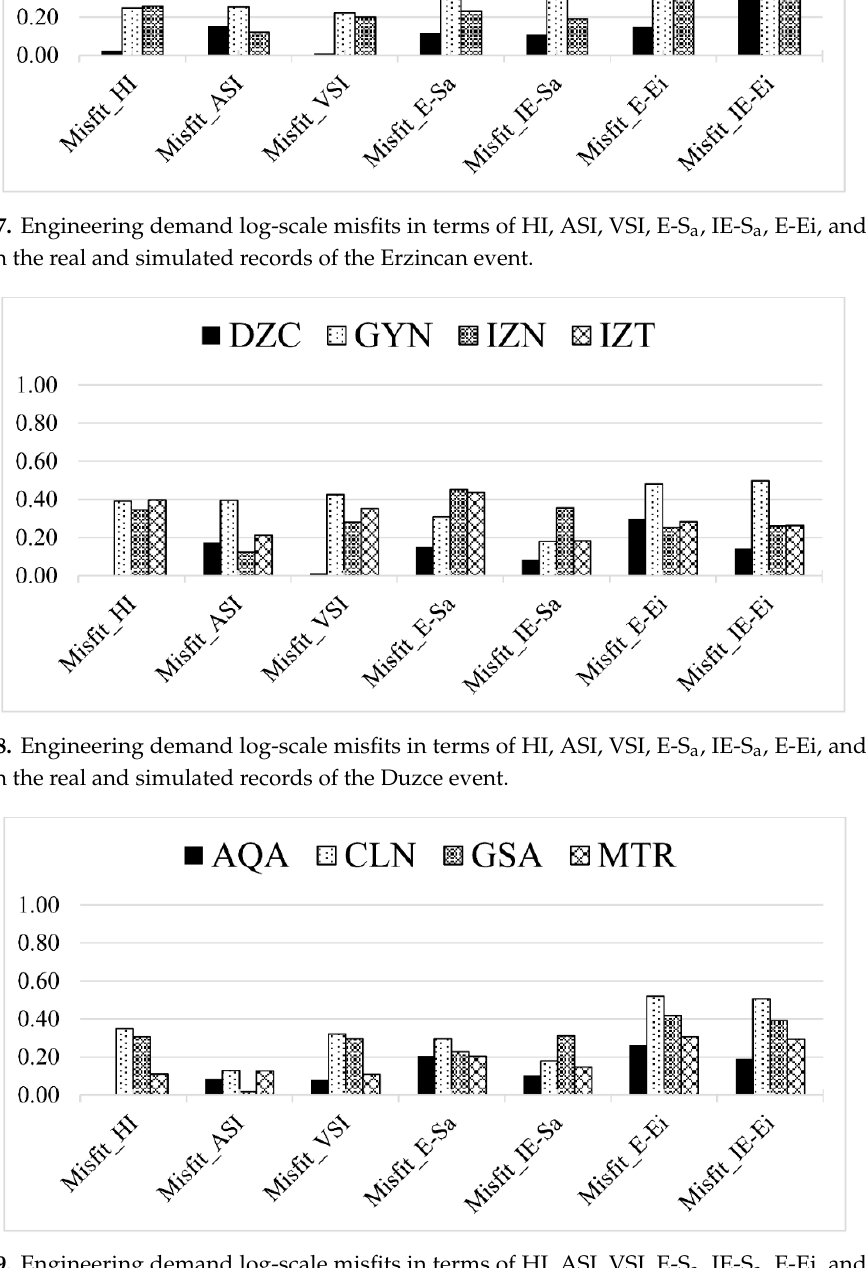
Figure 9. Engineering demand log-scale misfits in terms of HI, ASI, VSI, E-S a , IE-S a , E-Ei, and IE-Ei between the real and simulated records of the L’Aquila event.